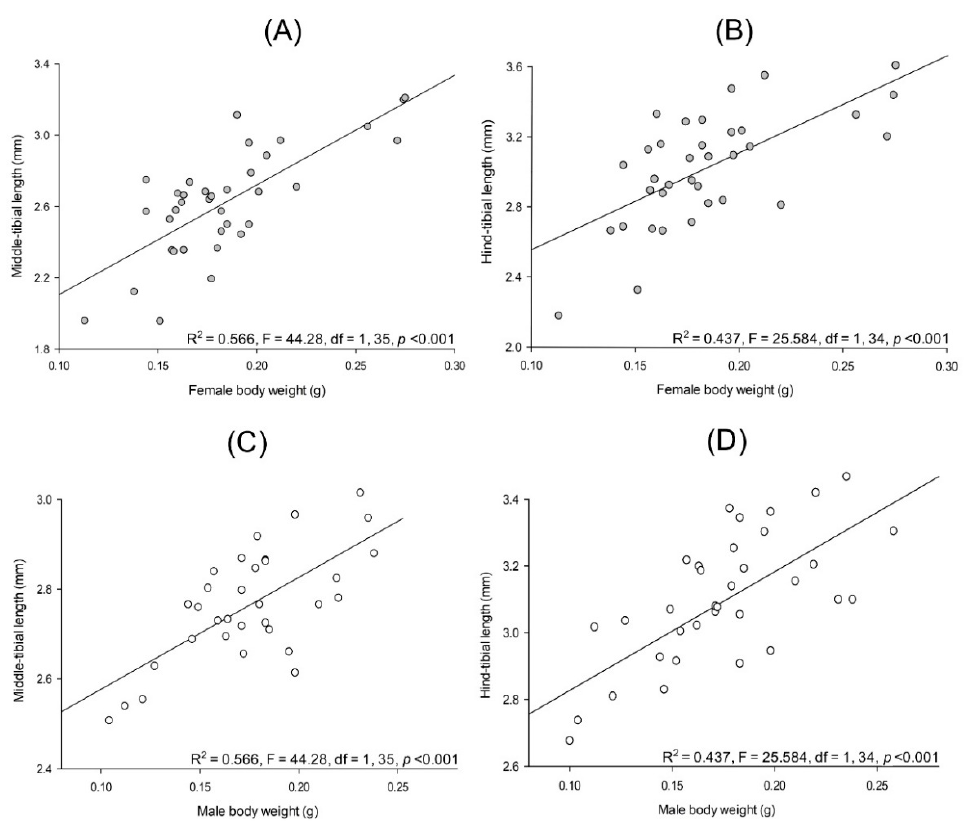
among male weight and his middle-tibial length (R 2 = 0.566, F = 44.28, df = 1, 35, p < 0.001, Figure 11C) and his hind-tibial length (R 2 = 0.437, F = 25.584, df = 1, 34, p < 0.001, Figure 11D) were observed. Standard error of mean = SEM.